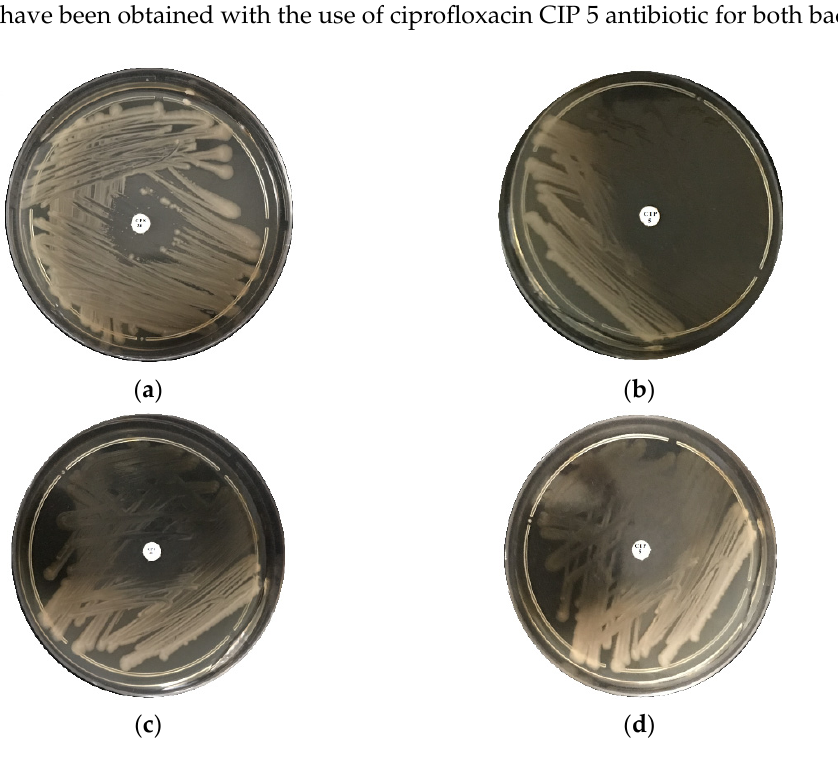
Figure 11. Antimicrobial behavior of ceftaroline fosamil CPS 30 ( a ), ciprofloxacin CIP 5 ( b ) against ISO SS and ceftaroline fosamil CPS 30 ( c ), ciprofloxacin CIP 5 ( d ) against E. coli